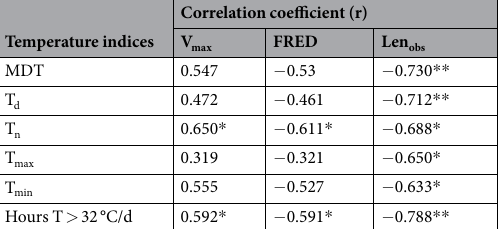
Table 5. Correlation coefficients for temperature indices and eigen-values of cotton fiber elongation with cotton cultivars of Simian 3 and Siza 3 under the elevated and ambient temperature regimes from 2010 to 2012. MDT, mean daily temperature; T d , mean daytime air temperature; T n , mean nighttime air temperature; T max , mean daily maximum air temperature; T min , mean daily minimum air temperature; FRED, fiber rapid-elongation duration; V max , the maximum fiber elongation rate; Len obs , observed fiber length; * and ** mean significant difference at 0.01 and 0.05 probability level, respectively; n = 12, R 0.05 = 0.576, R 0.01 =